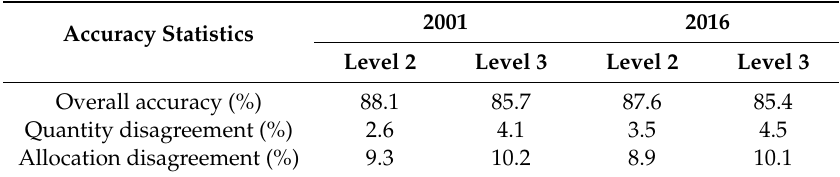
Table 1. Results of the accuracy assessment of the levels 2 and 3 of the 2001 and 2016 classifications of Collection 4.0 MapBiomas land use and land cover maps (for information on quantity and allocation disagreement statistics see [52]).